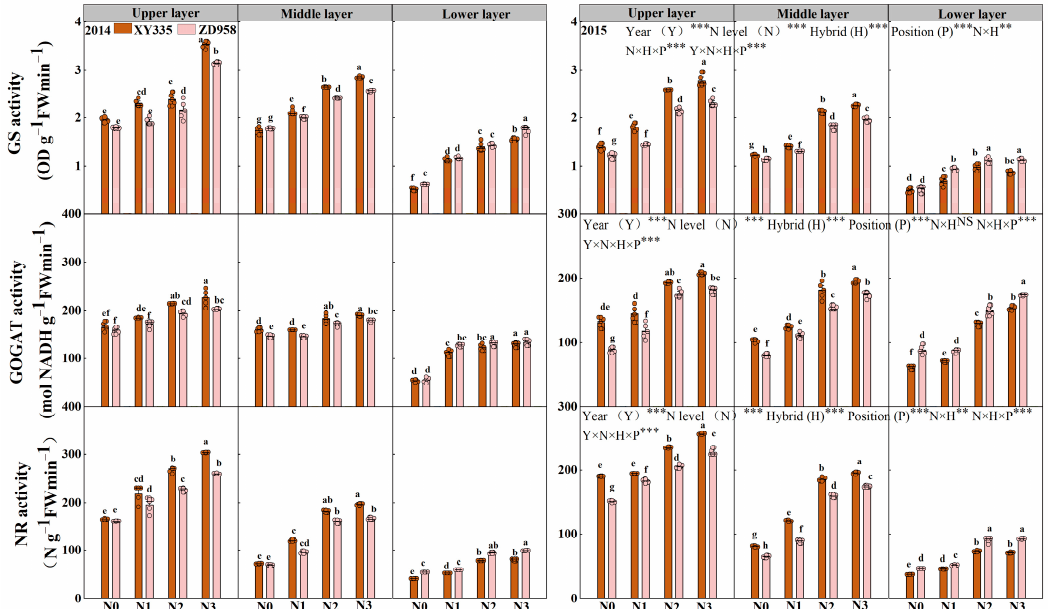
Figure 3. N content and remobilization in different maize genotypes at a high plant density in 2014 and 2015. N0, N1, N2, and N3 indicate applications of 0, 100, 200, and 300 kg N ha − 1 , respectively. Different letters indicate a significant difference at the 5% level. Values are shown as the mean ± SE ( n = 3).